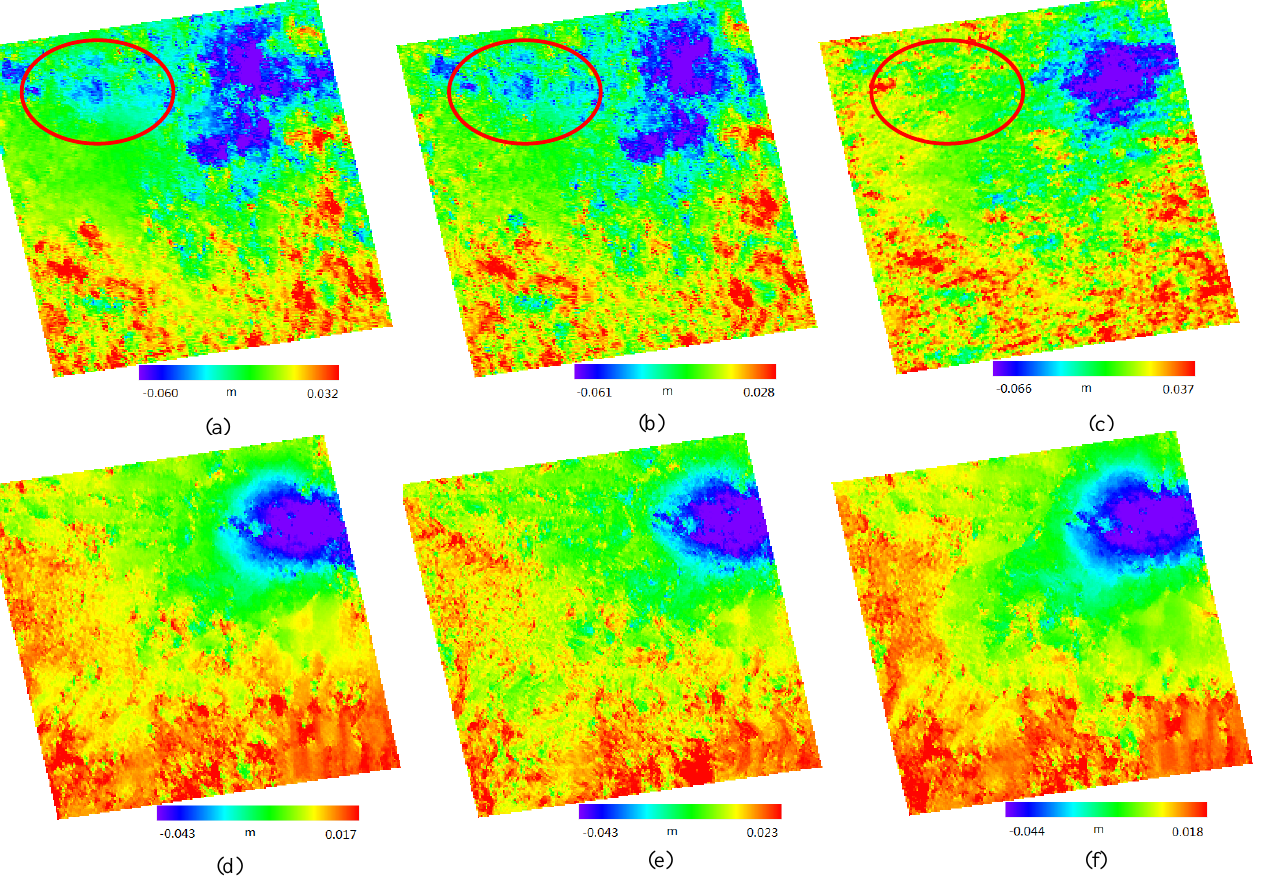
Figure 2. Displacement figures of Radarsat-2 and TerraSAR with different DEM (a) Displacement figure of Radarsat-2 with SRTM; (b) Displacement figure of Radarsat-2 with GDEM; (c) Displacement figure of Radarsat-2 with LiDAR DEM; (d) Displacement figure of TerraSAR with SRTM; (e) Displacement figure of TerraSAR with GDEM; (f) Displacement figure of TerraSAR with LiDAR DEM